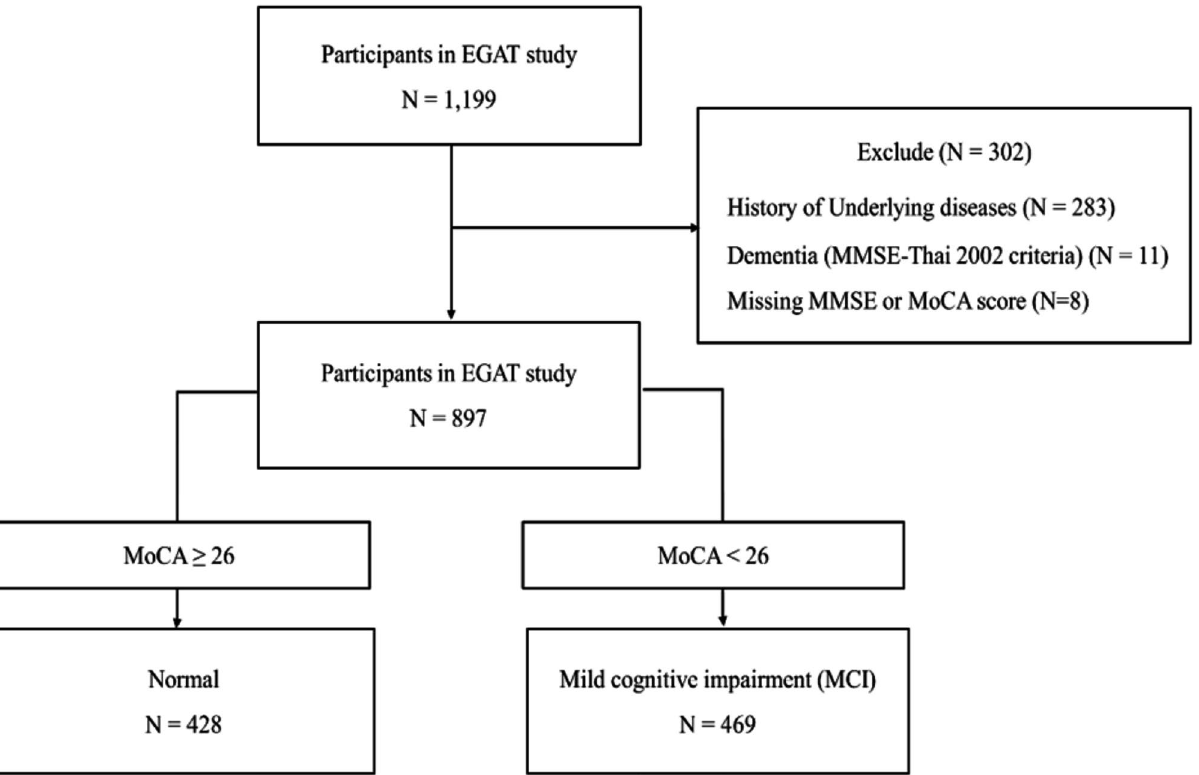
Figure 1. Study protocol for this study. 897 participants from the EGAT cohort were classified to be in the normal cognition group (n = 428) or mild cognitive impairment group (n = 496), according to their MoCA score, and the association between cognitive function and mitochondrial function in PBMCs were